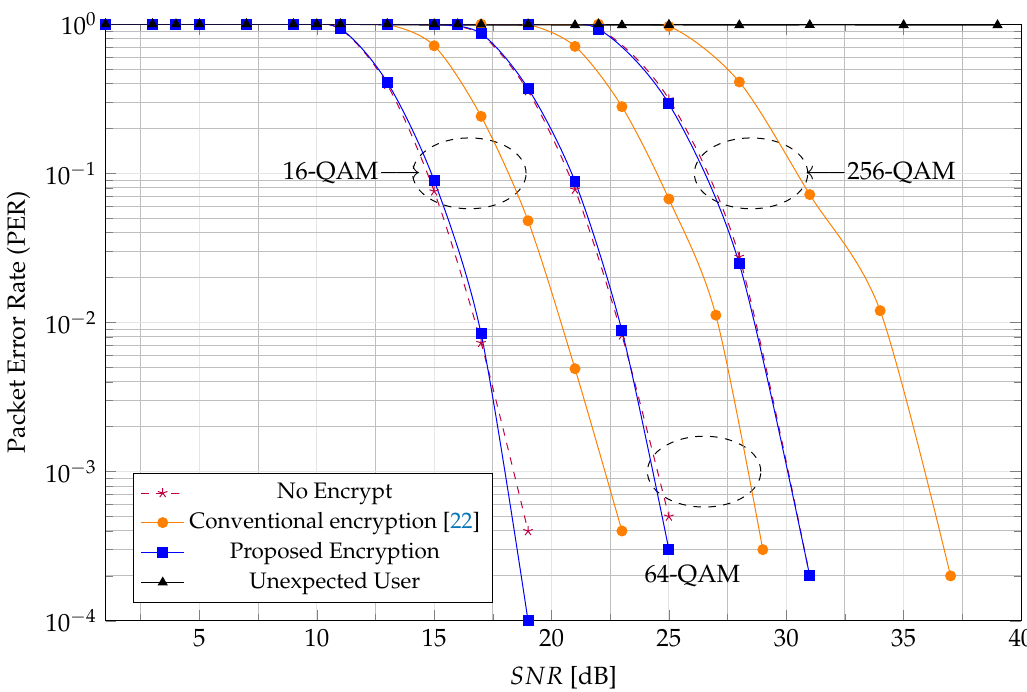
Figure 9. PER performance of 802.11ah with 16-QAM, 64-QAM, and 256-QAM using AWGN